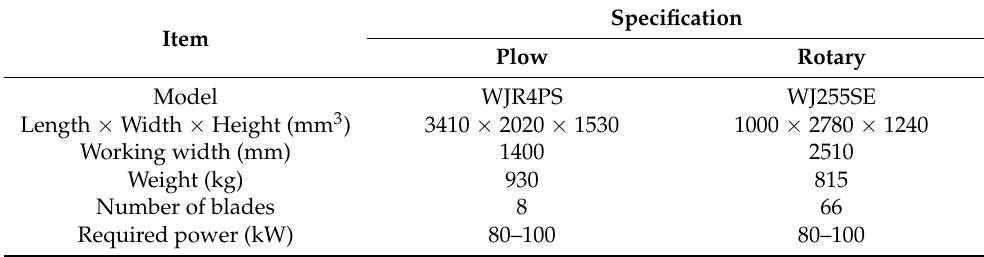
Table 2. Specifications of the attached implements for tractor used in this study.